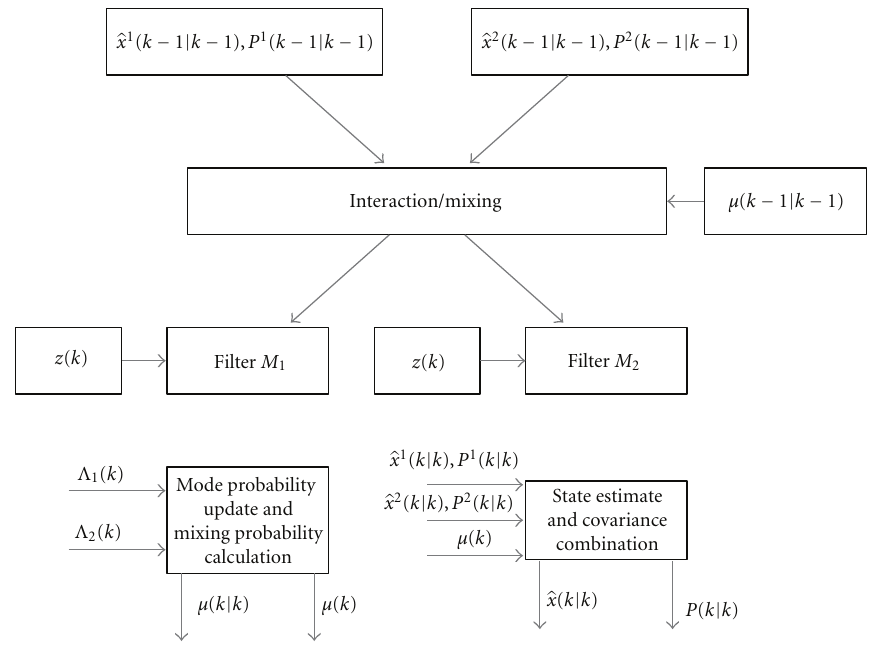
Figure 5: Outline of an interacting multiple-model